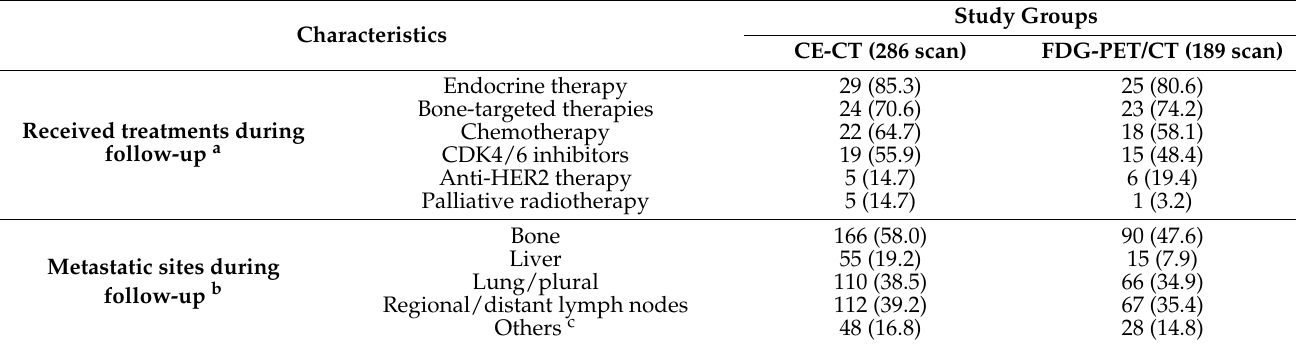
Table 3. Treatment regimens and detected metastasis during